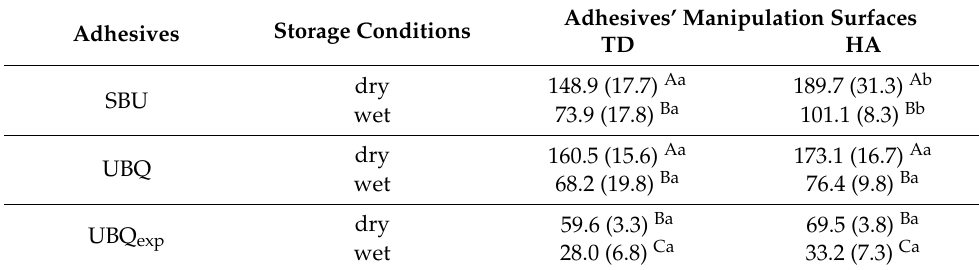
Table 4. Mean (SD) values (MPa) of the flexural strength ( n = 8).